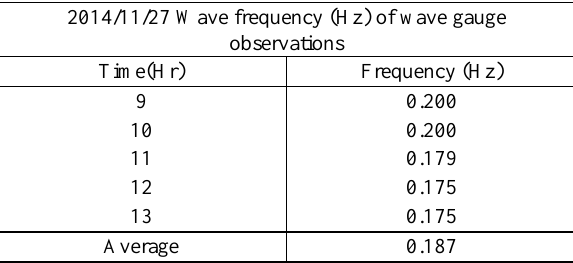
Table 1. Wave frequency of Anping wave gauge observations on November 27, 2014.